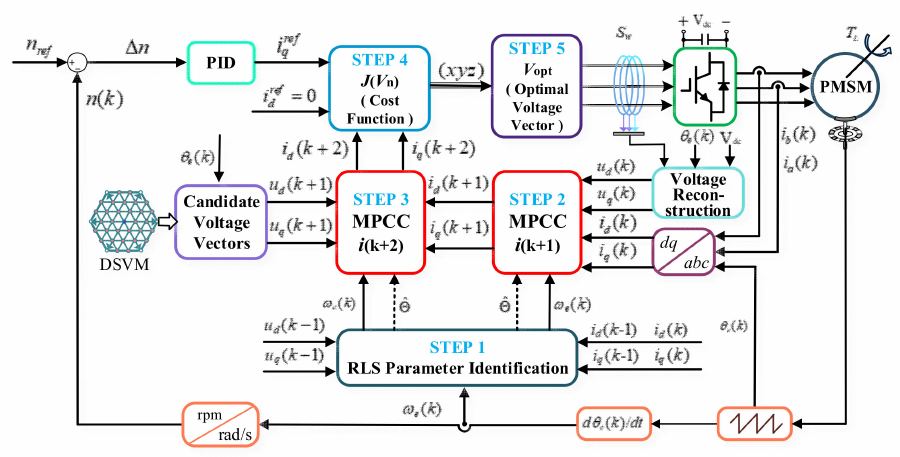
Figure 3. The control structure of